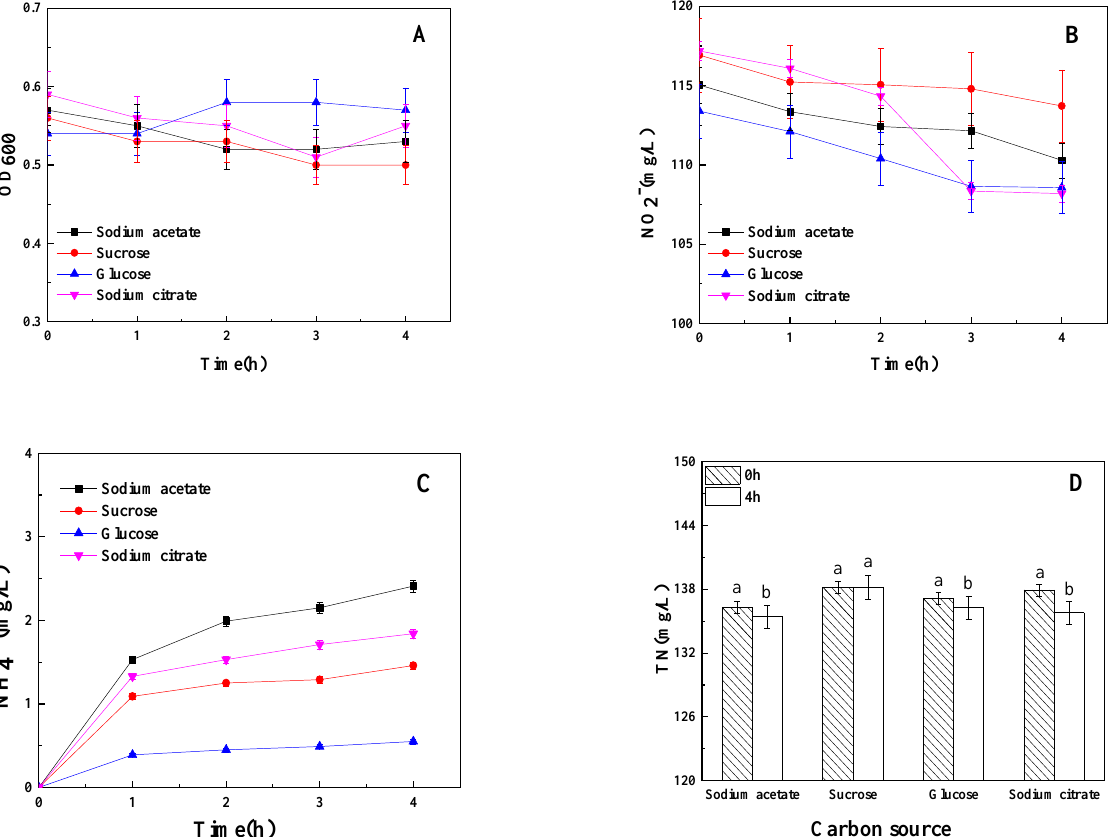
Figure 2. Influence of carbon source on OD 600 ( A ), NO 2 − ( B ), NH 4+ ( C ), and TN ( D ) by strain Y-9. Values are means ± SD for triplicates. Different letters indicate significant differences between treatments at p < 0.05.